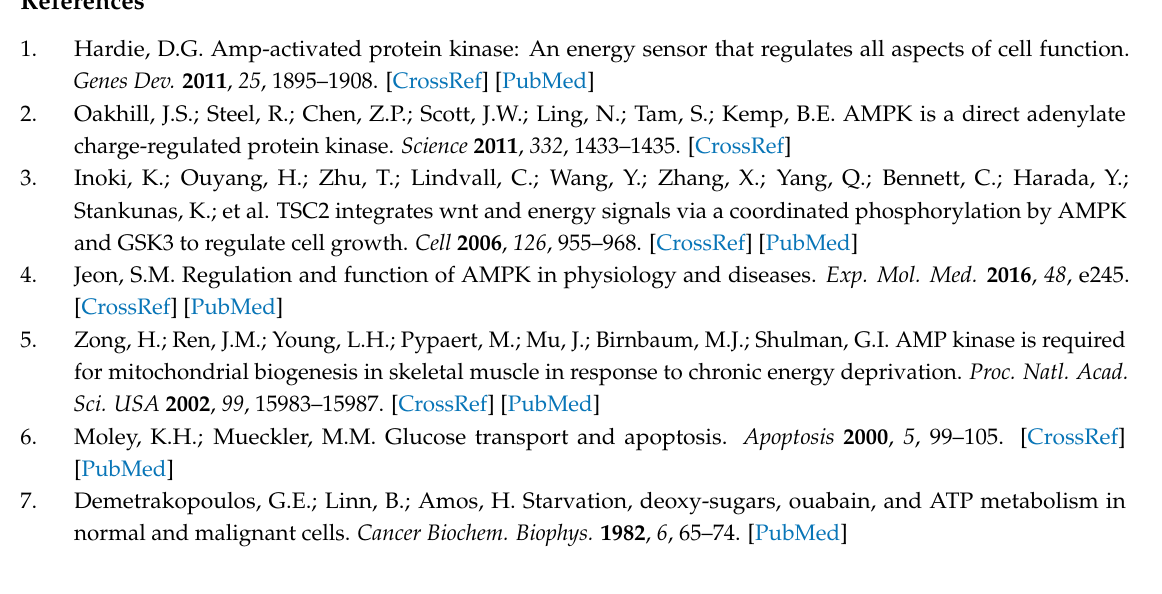
Figure S1: Changes in total ATP level and mitochondrial ATP production and cell proliferation rates in different fibroblasts lines, Figure S2: Changes in the levels of phosphor AMPK, superoxides, and mitochondria content in HCT116 or MCF7 cells, Figure S3: Mitochondrial elongation upon glucose withdrawal, Figure S4: Effects of lowered glucose supply on the levels of mitochondria content and ROS, Figure S5: Changes in mitochondrial ATP production and oxygen consumption per unit mass of mitochondria, Figure S6: Effect of glucose withdrawal on cancer cell proliferation, Figure S7: Sequences of primers used for quantitative